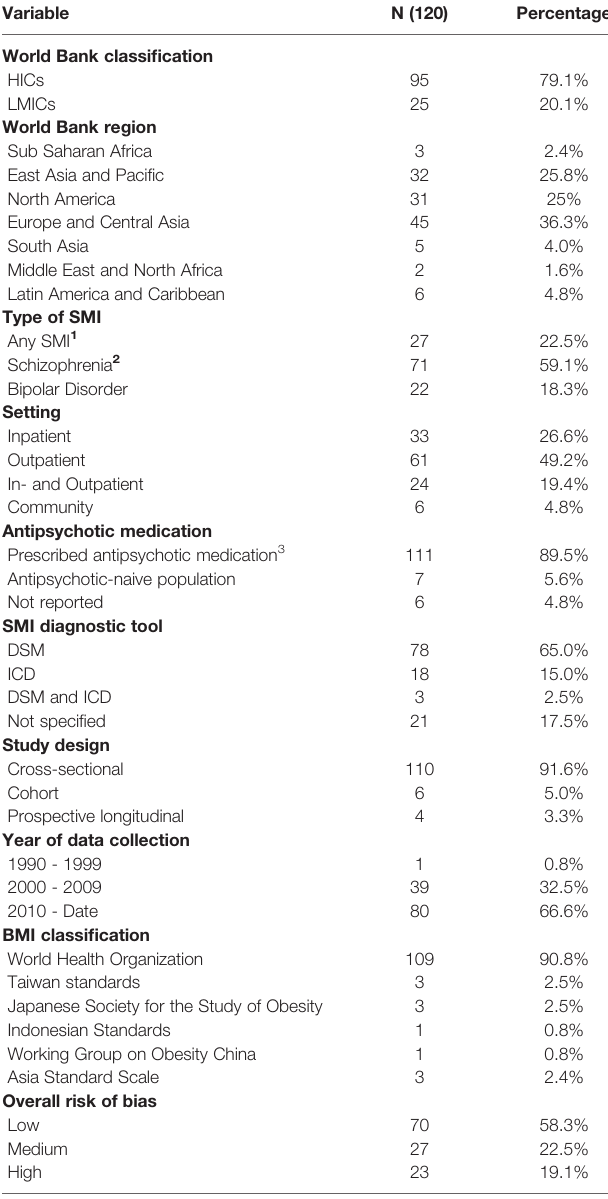
TABLE 1 | Summary of the